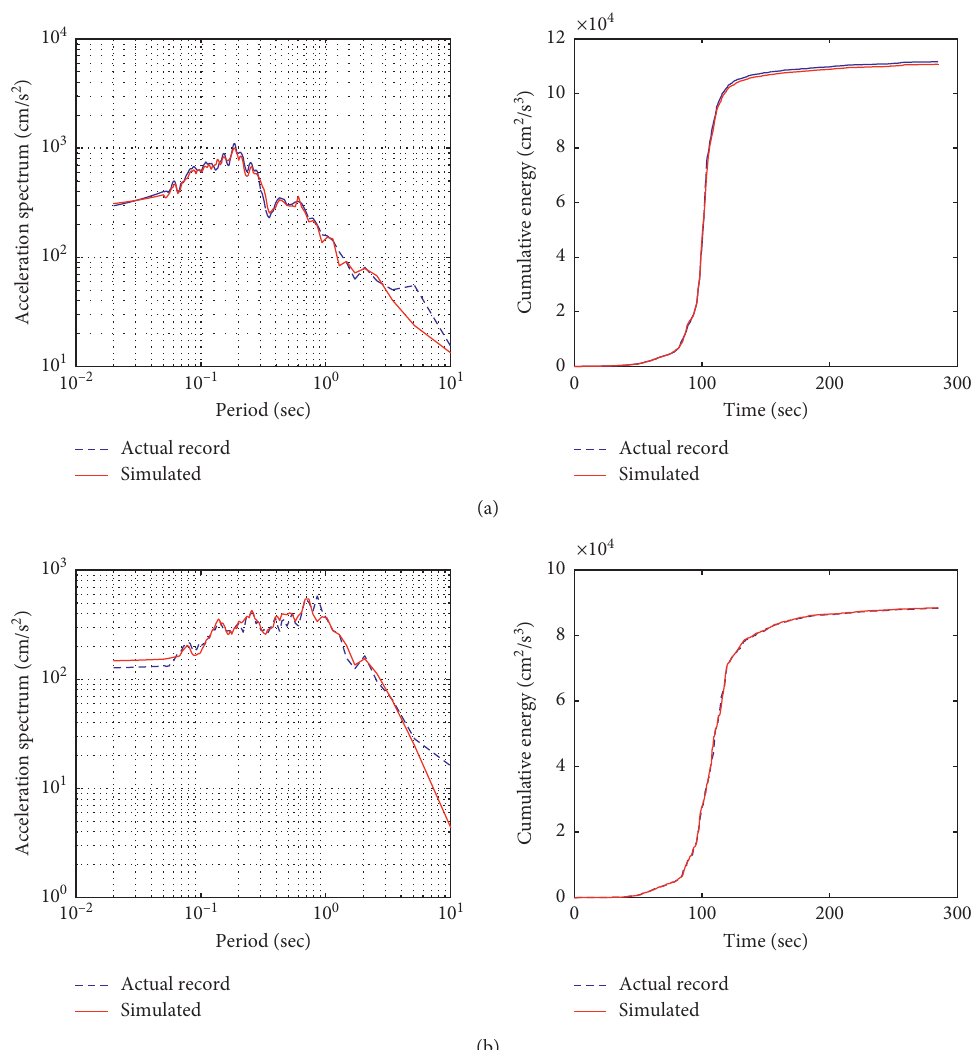
Figure 16: Comparison of simulated high-frequency components with the records with respect to response spectrum and cumulative energy curve. (a) CHB002EW and (b)